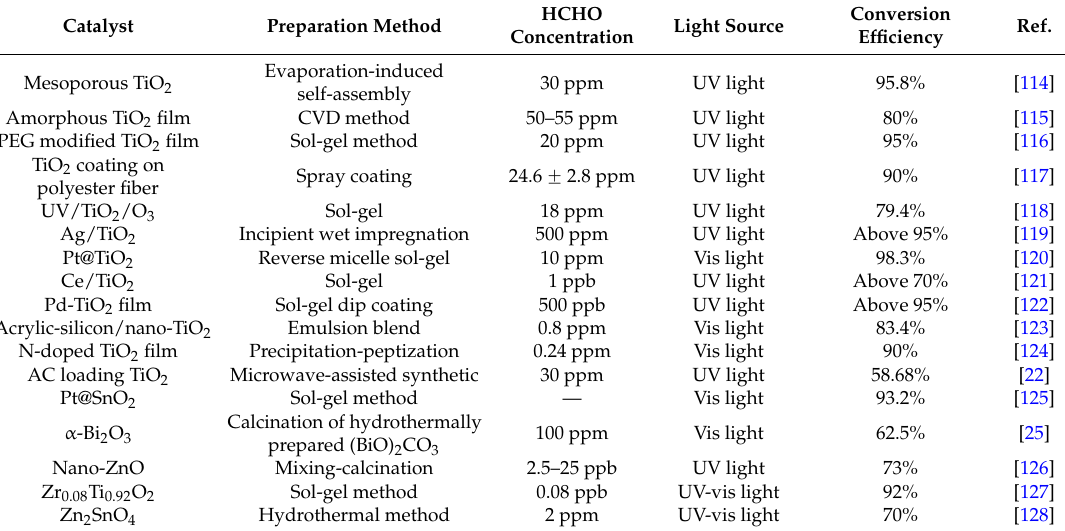
Table 5. Summary of the PCOs used for formaldehyde